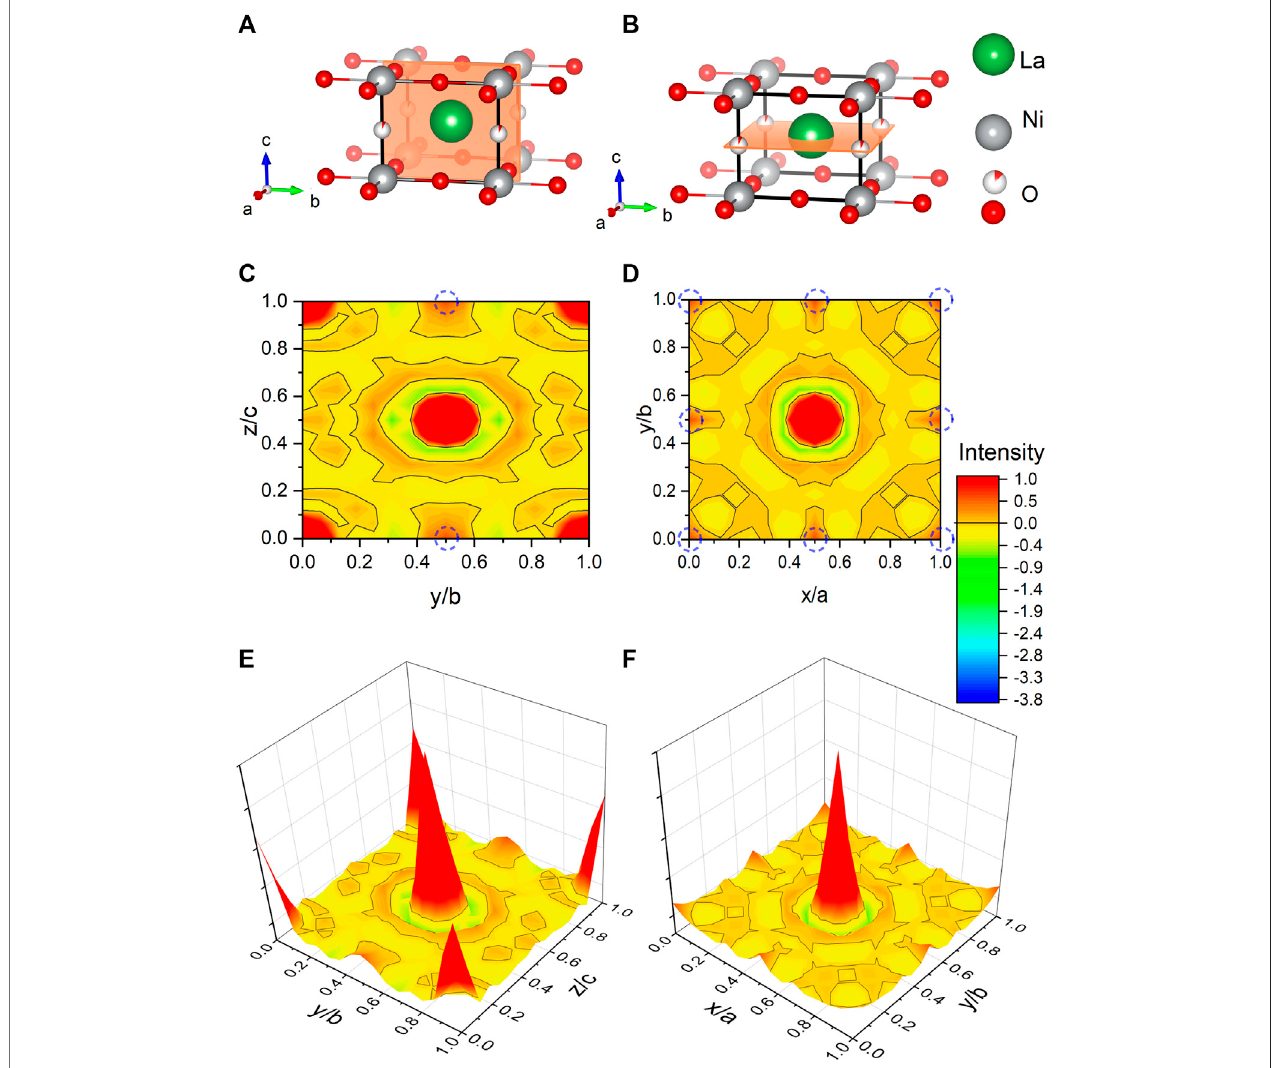
FIGURE 4 | Fourier maps of the scattering length density within the unit cell of LaNiO 2 extracted from neutron powder diffraction. (A,B) Re fi ned unit cells with cuts correspondingtotheFouriermapsin (C,D) ,withtheintensityrangefocusedonthenegativescatteringlength(yellow toblue),with − 3.74 fmcorrespondingtohydrogen [40]. The positive scattering (orange to red) is capped at 1 (with 5.8 fm corresponding to oxygen). The black lines mark the isosurface lines with zero scattering intensity. The theoretically proposed hydrogen positions [23, 24] are highlighted with blue dashed circles. (E,F) Fourier maps are shown as a 3D colormap.